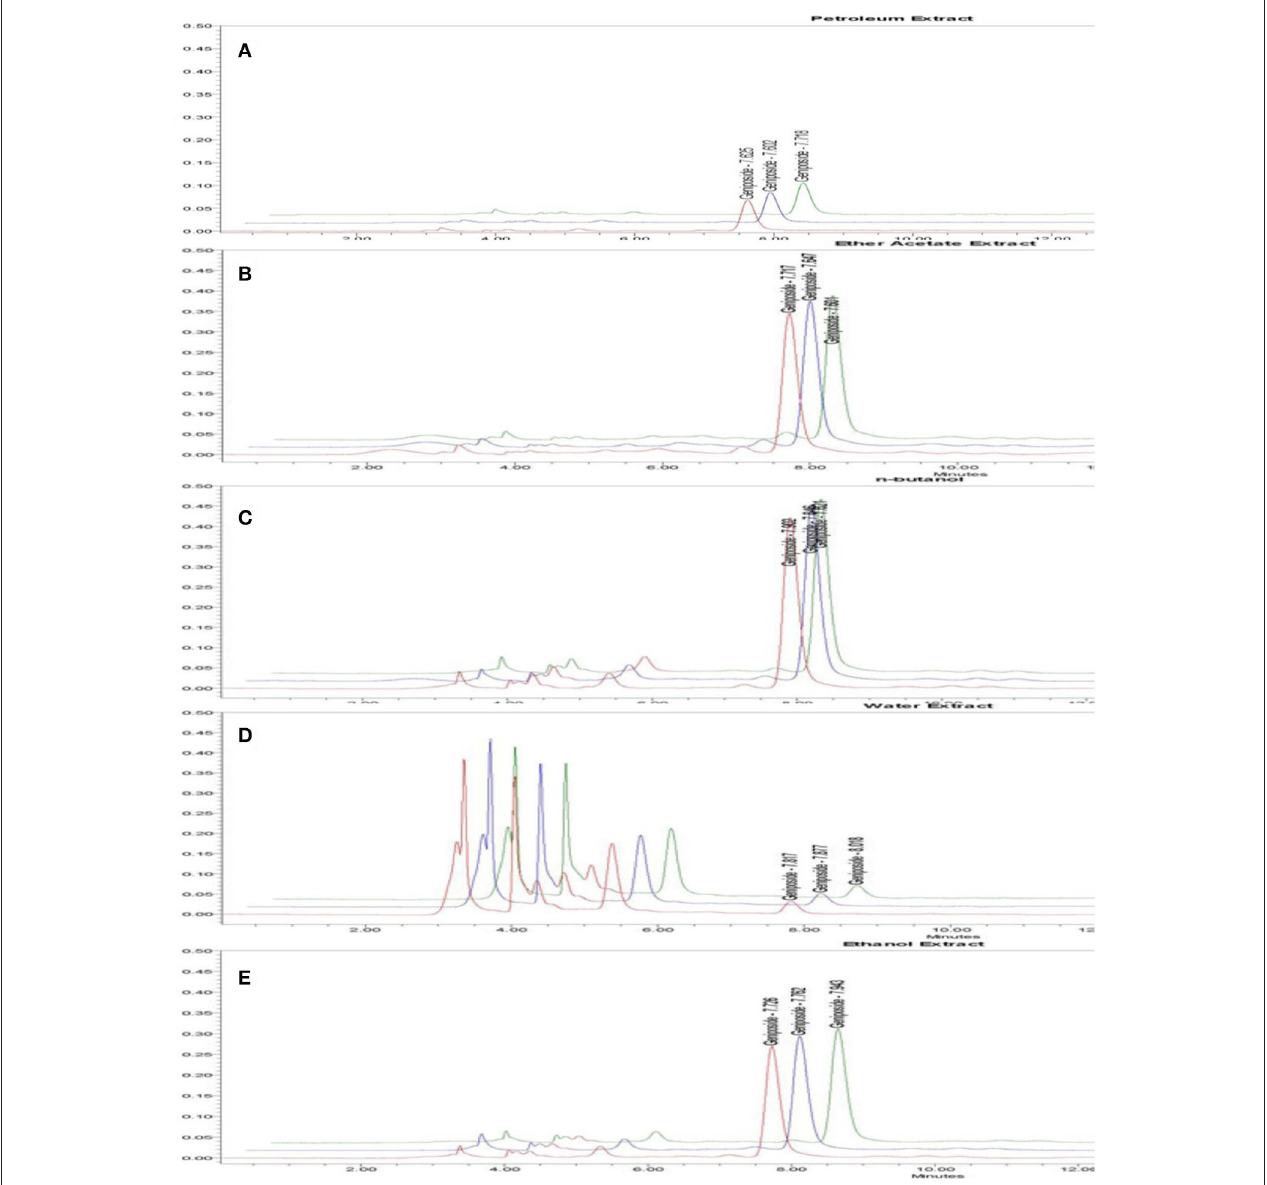
FIGURE 6 | HPLC chromatogram of geniposide from different fractions derived from GJE. Time (min) as unit of Y-axis and chromatographic profiles are reported at 240nm. The contents of geniposide are shown in petroleum fraction (A) , Ethyl acetate fraction (B) , N-butanol fraction (C) , Water fraction (D) , Ethanol fraction (E)